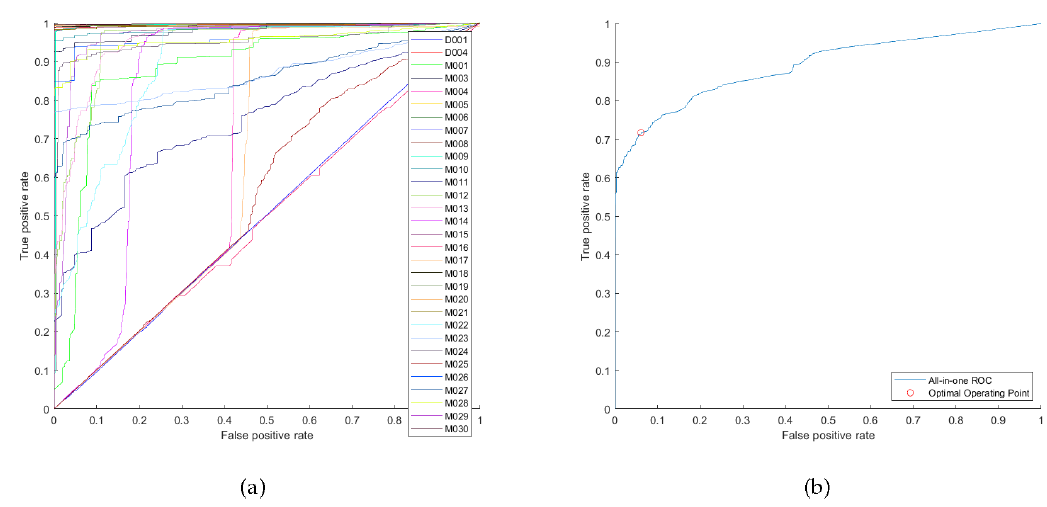
Figure 7. Using sliding window size of 60 s, minimum relative support 5% and minimum confidence of 50%: ( a ) ROC curves of failure detection when each consequent sensor has fail-stop failure. ( b ) All-in-one ROC